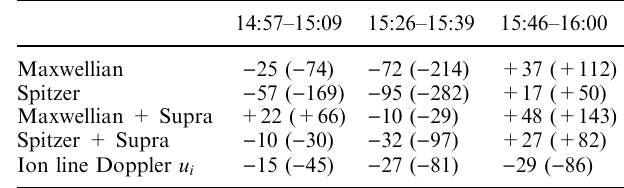
Table 1. Mean value of the electron Doppler velocity u e for the four di(cid:128)erent models considered: a Maxwellian, a Spitzer function, a Maxwellian superimposed with a suprathermal distribution and a Spitzer superimposed with a suprathermal distribution as well as the ion Doppler velocity u i estimated from the ion line analysis. The suprathermal distribution is the one shown in Fig. 8 and the parameters of the Spitzer function are the one of Figure 6. The mean Doppler are calculated for the three time intervals considered. The first number in each column is the velocity in ms ) 1 while the number in parenthesis is the equivalent frequency Doppler shift in